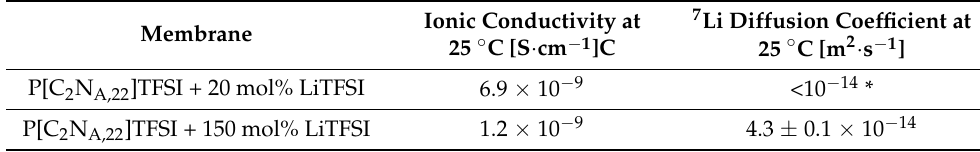
Table 4. Ionic condutivity values and diffusion coefficient of P[C 2 N A,22 ]TFSI with 20 mol% and 150 mol% LiTFSI at 25 ◦ C.